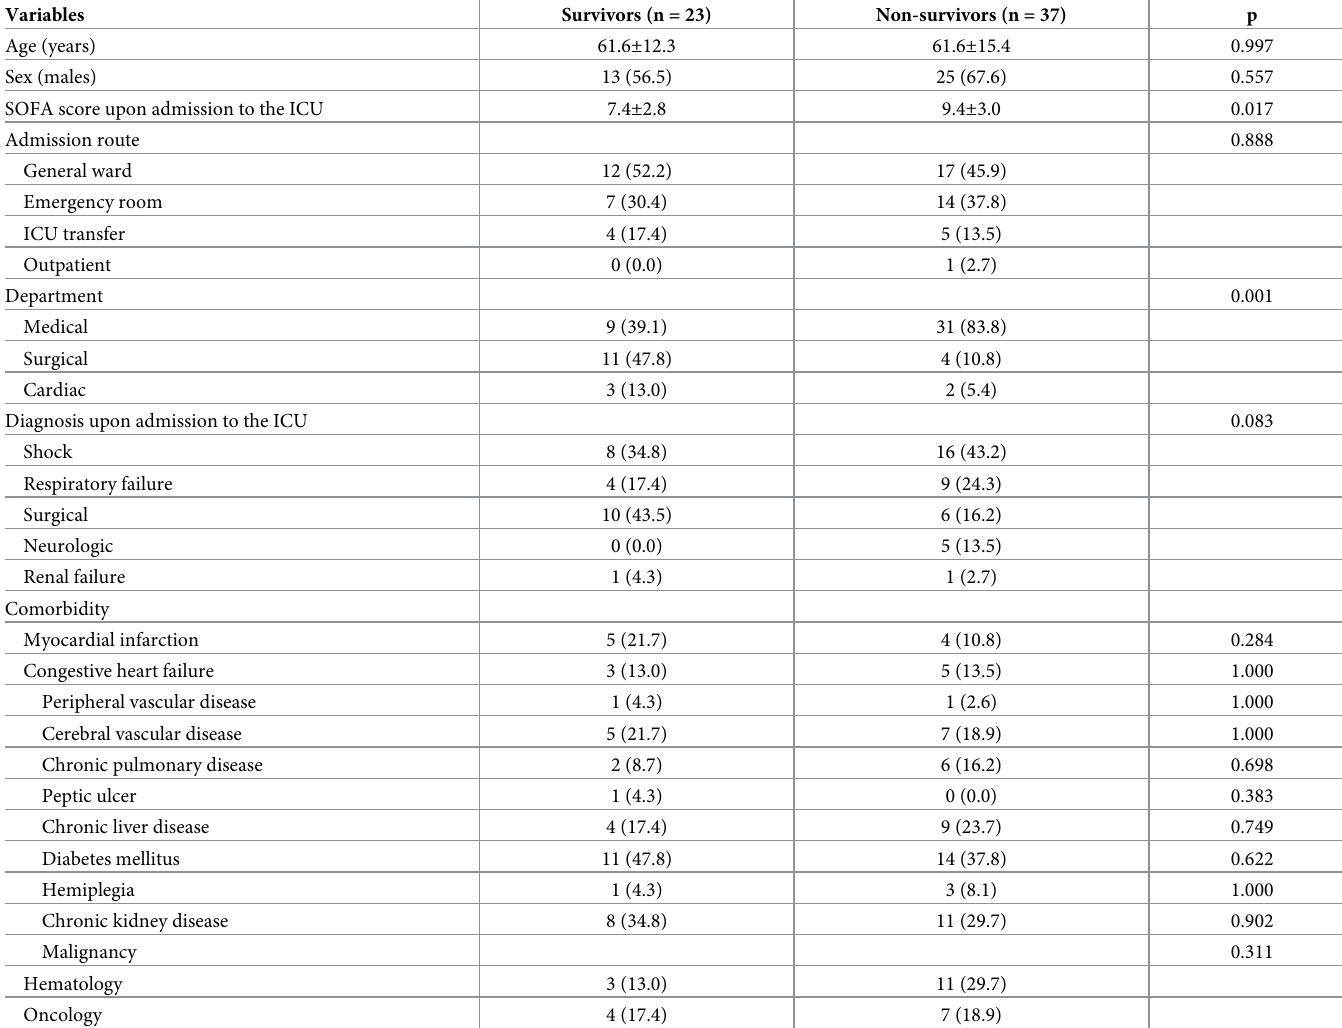
Table 1. Baseline characteristics of the study